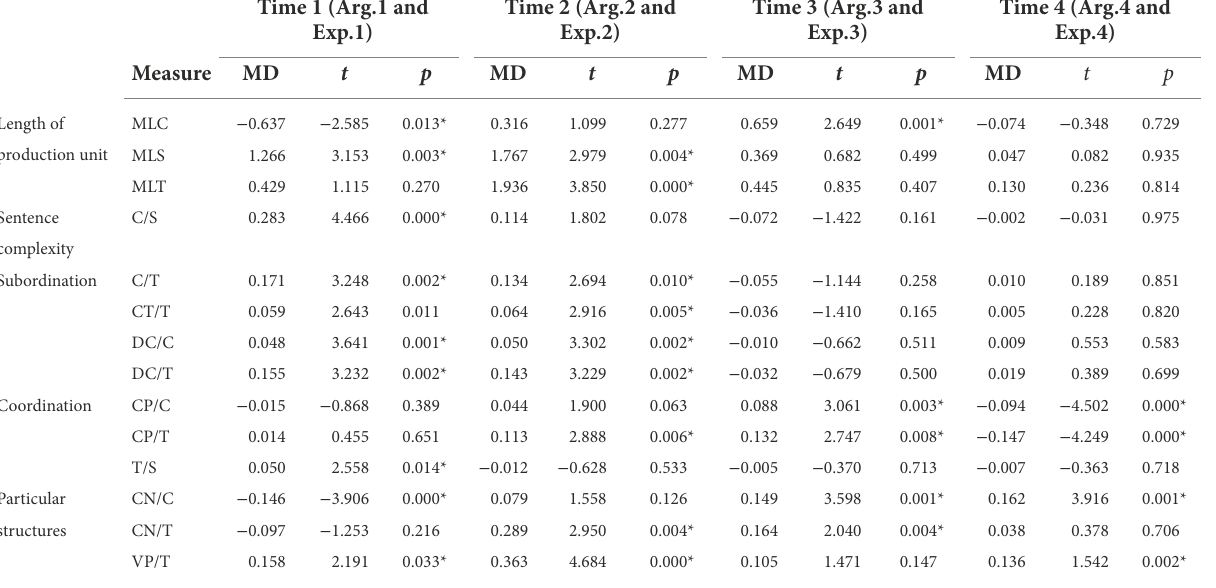
TABLE 5 Mean differences (MD) in syntactic complexities and standard deviations by time point and genre. Time 1 (Arg.1 and Exp.1)